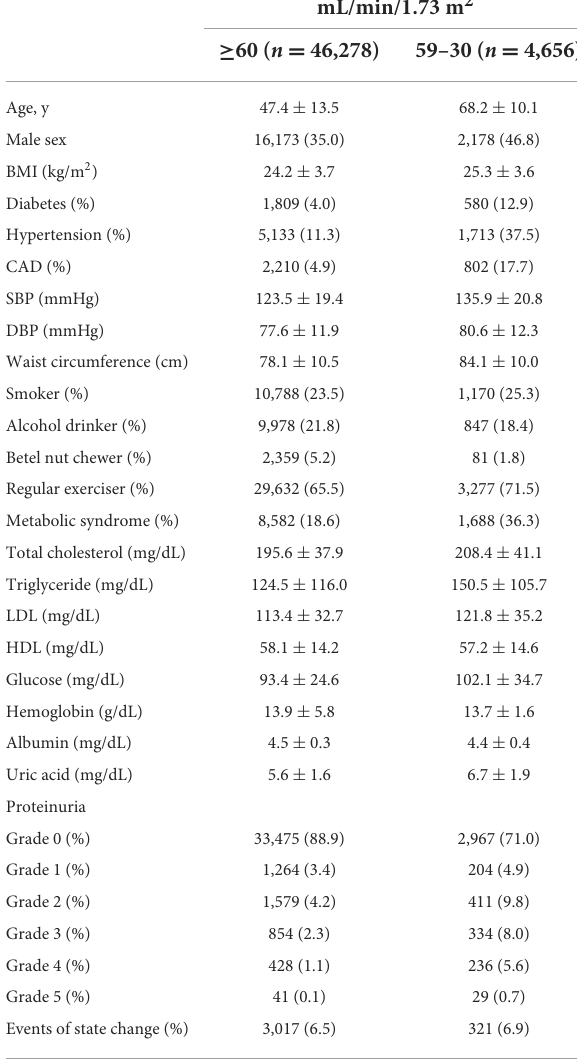
TABLE 1 Baseline characteristics of the study